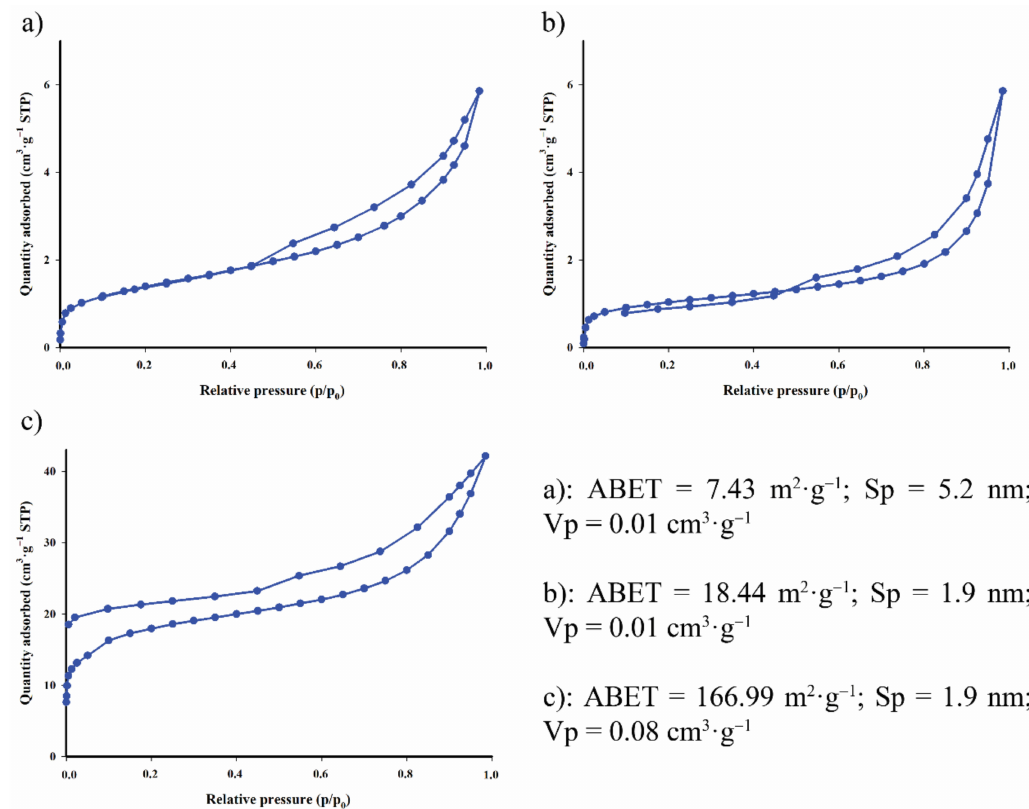
Figure 2. N 2 adsorption/desorption isotherm of carbon material obtained at 673.15 K ( a ), 773.15 K ( b ) and 973.15 K ( c